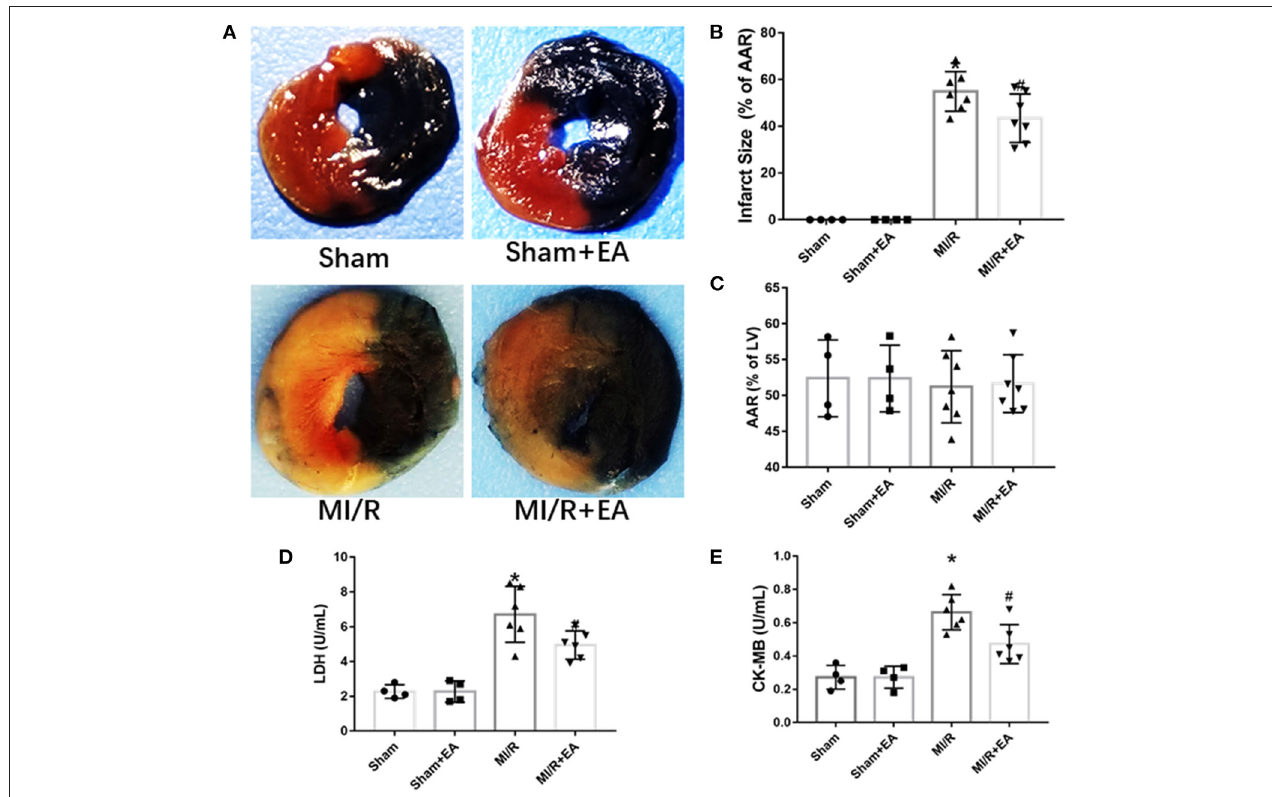
FIGURE 2 | The effects of EA pretreatment on myocardial infarct size, LDH, and CK-MB activities in MI/R-induced cardiac injury. (A) Representative images of cardiac slices by TTC/Evans blue double staining in MI/R-induced cardiac injury following EA pretreatment. (B) Myocardial infarct size of different groups. (C) Myocardial area at risk (AAR) following MI/R procedure and EA treatment. n = 4–7 in each group for TTC/Evans blue double staining. (D) Serum LDH activity. (E) Serum CK-MB activity. n = 4–6 in each group for enzyme activity measurements. LDH, lactate dehydrogenase; CK-MB, creatine kinase-MB isoform; EA, electroacupuncture; MI/R,